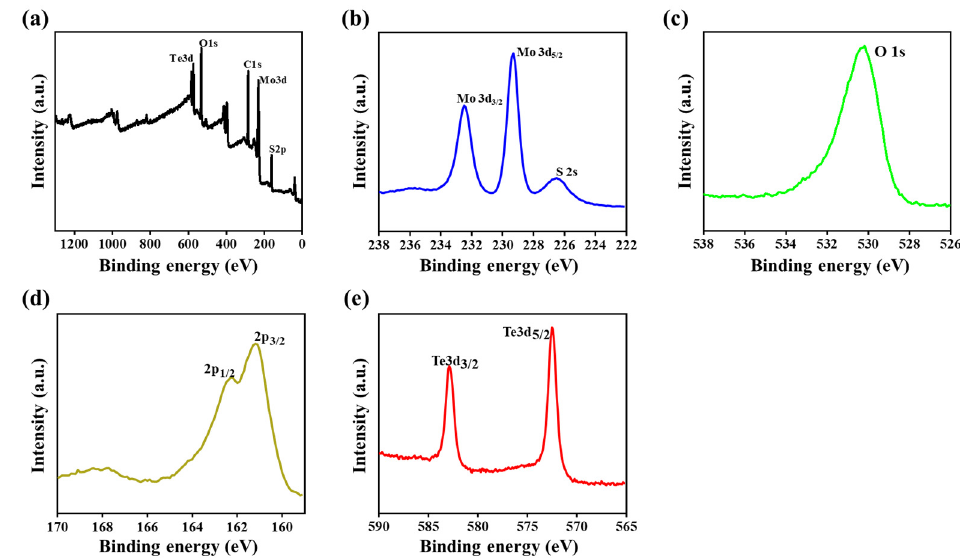
Figure 3. XRD and FTIR analyses of samples: ( a ) XRD spectra and ( b ) FTIR spectra.